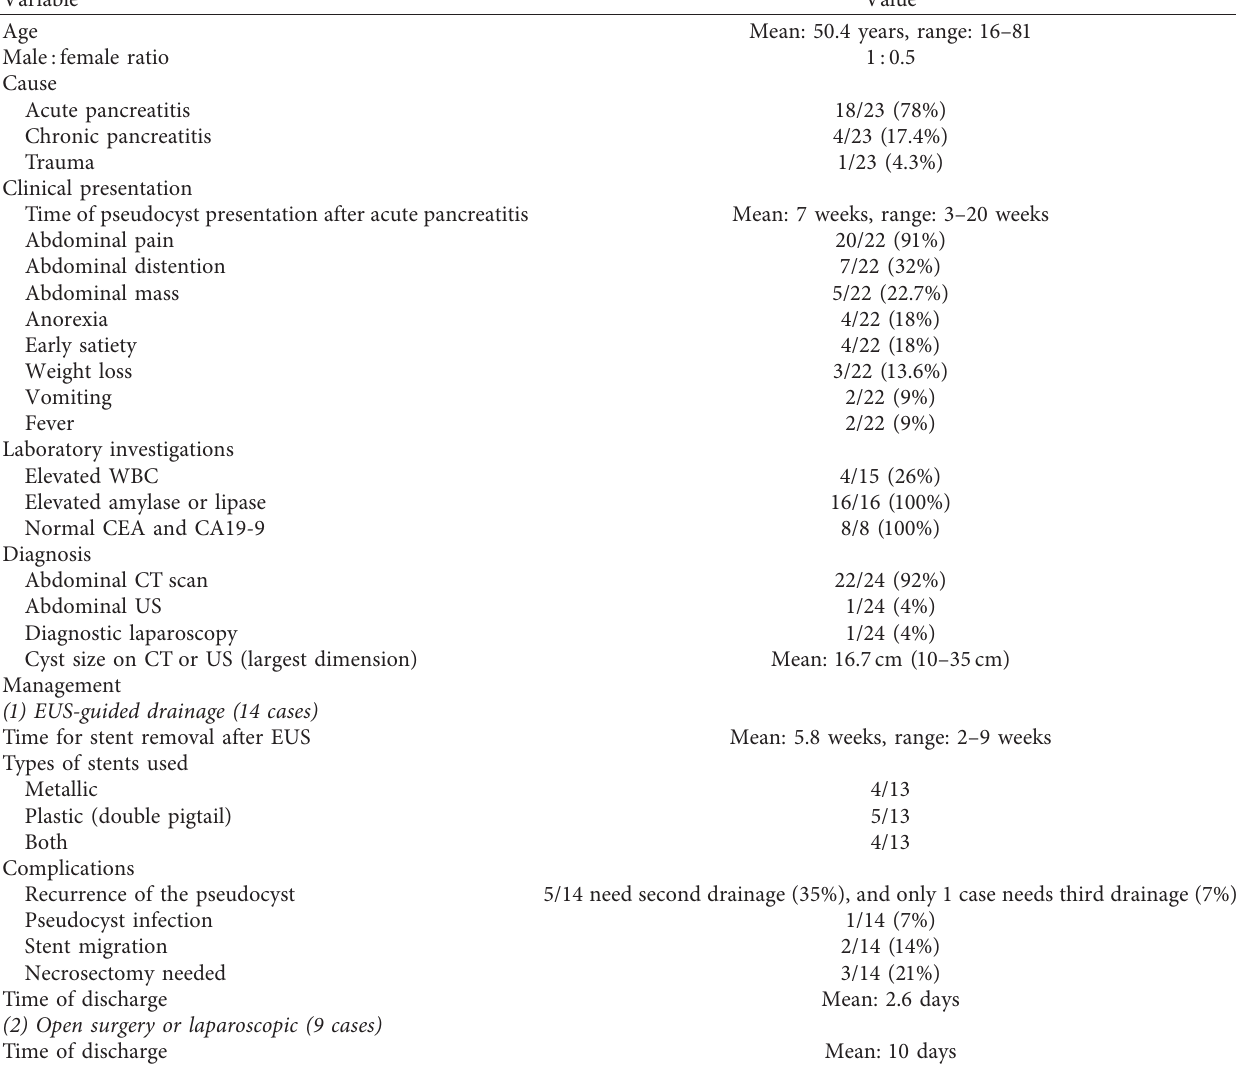
Table 2: Characteristics of the 24 most reported giant pancreatic